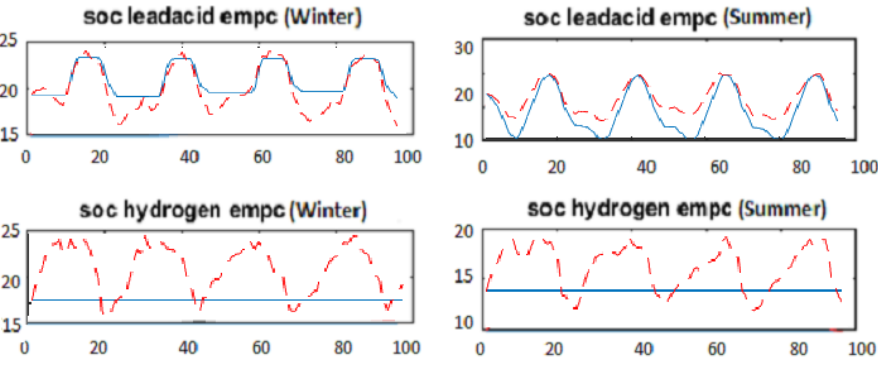
Figure 8. Sample plots of batteries’ State of Charge.